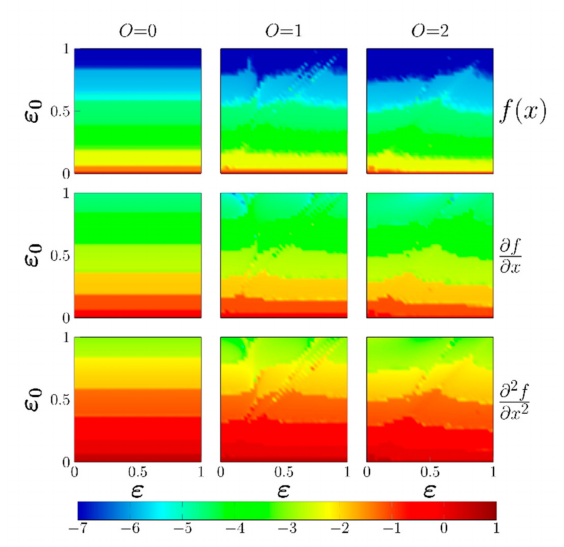
Figure 5. The log10 of the norm of the error of approximating the given function f ( x ) and its first two derivatives using Gaussian RBF-TS with different truncation orders for a range of ε and ε 0 values. The rows are for function, first derivative, and second derivative approximation, while the columns are for the zeroth, first, and second orders of